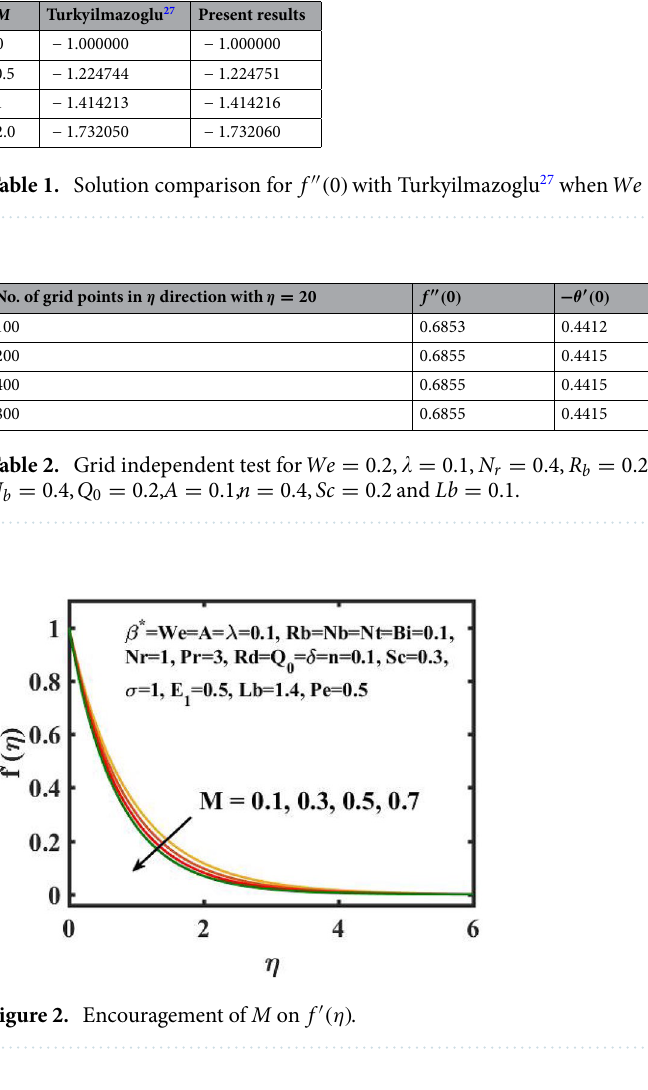
Figure 2. Encouragement of M on f ′ (η)